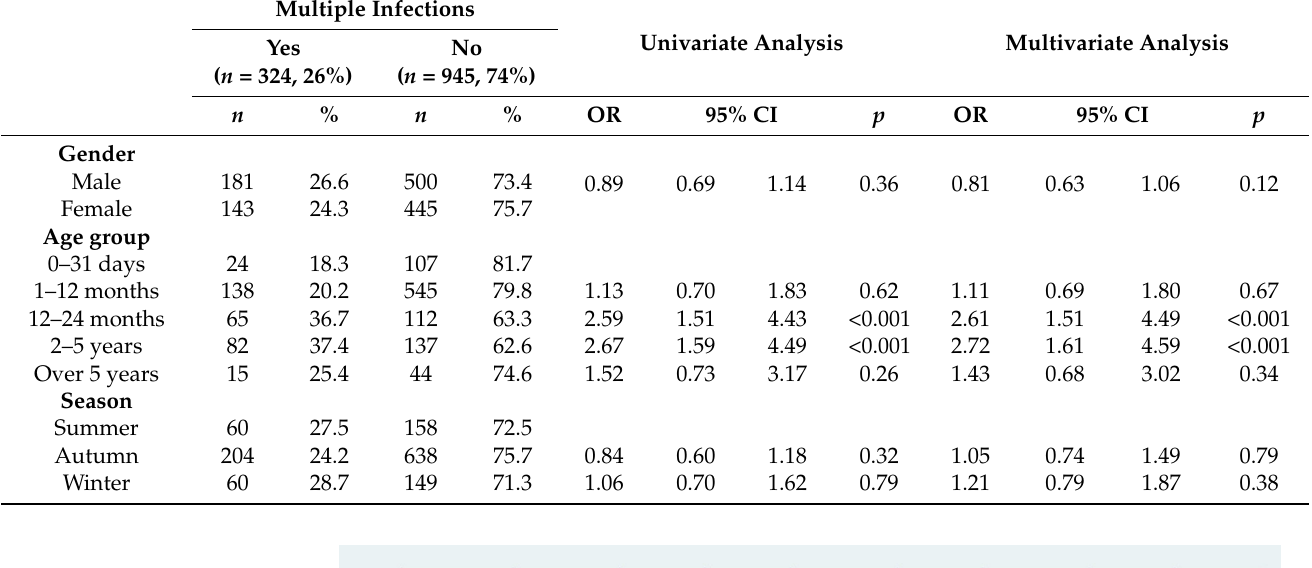
Table 2. Multivariable and univariate logistic regression models for independent variables associated with presence/absence of multiple infections.